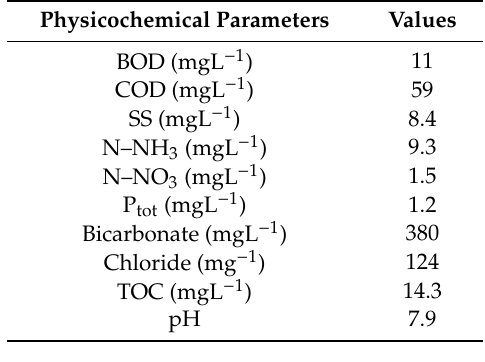
Table 4. Physisochemical characteristics of the wastewater e ffl uent.